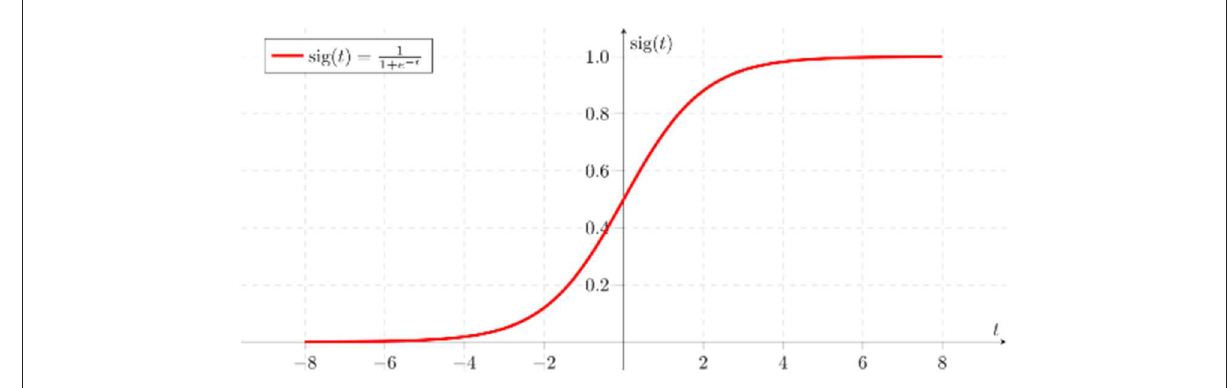
FIGURE4 Sigmoid function used in logistic regression.